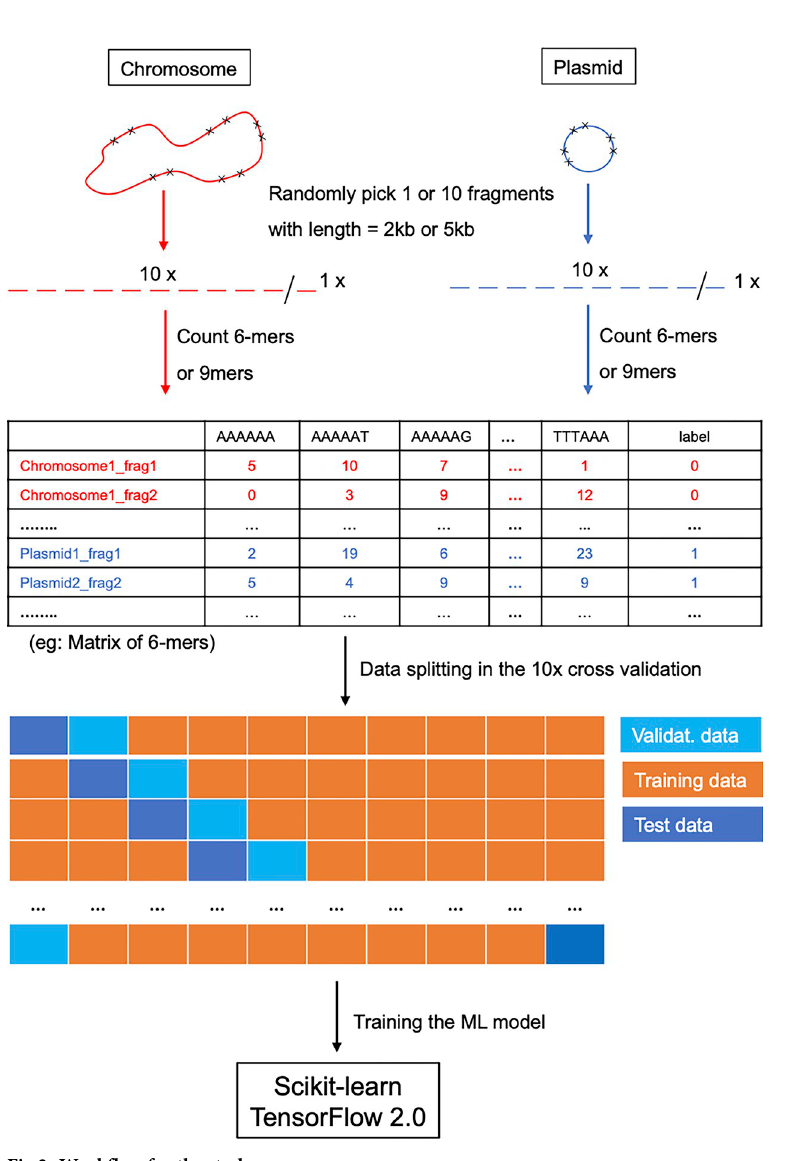
5kb samples were used to build models, all plasmid contigs less than 5kb in length were excluded from the analysis. The dataset (exempting the holdout set) was split by 7:2:1 ratio for model training, testing, and validation, respectively.